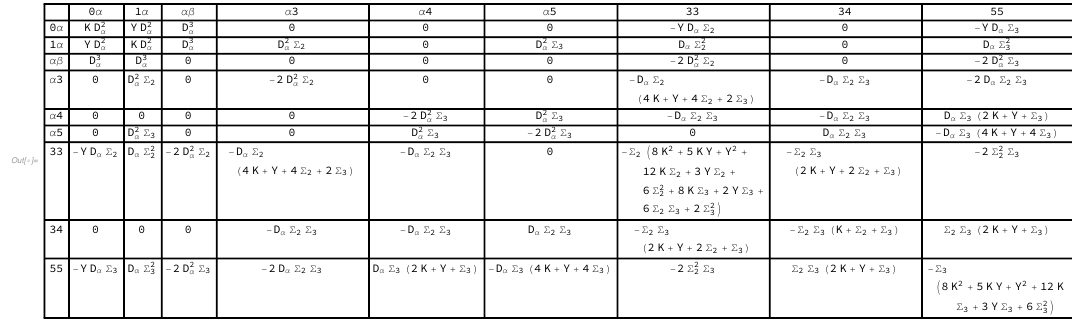
for the reduced intersection pairing M red ( IJ )( KL )